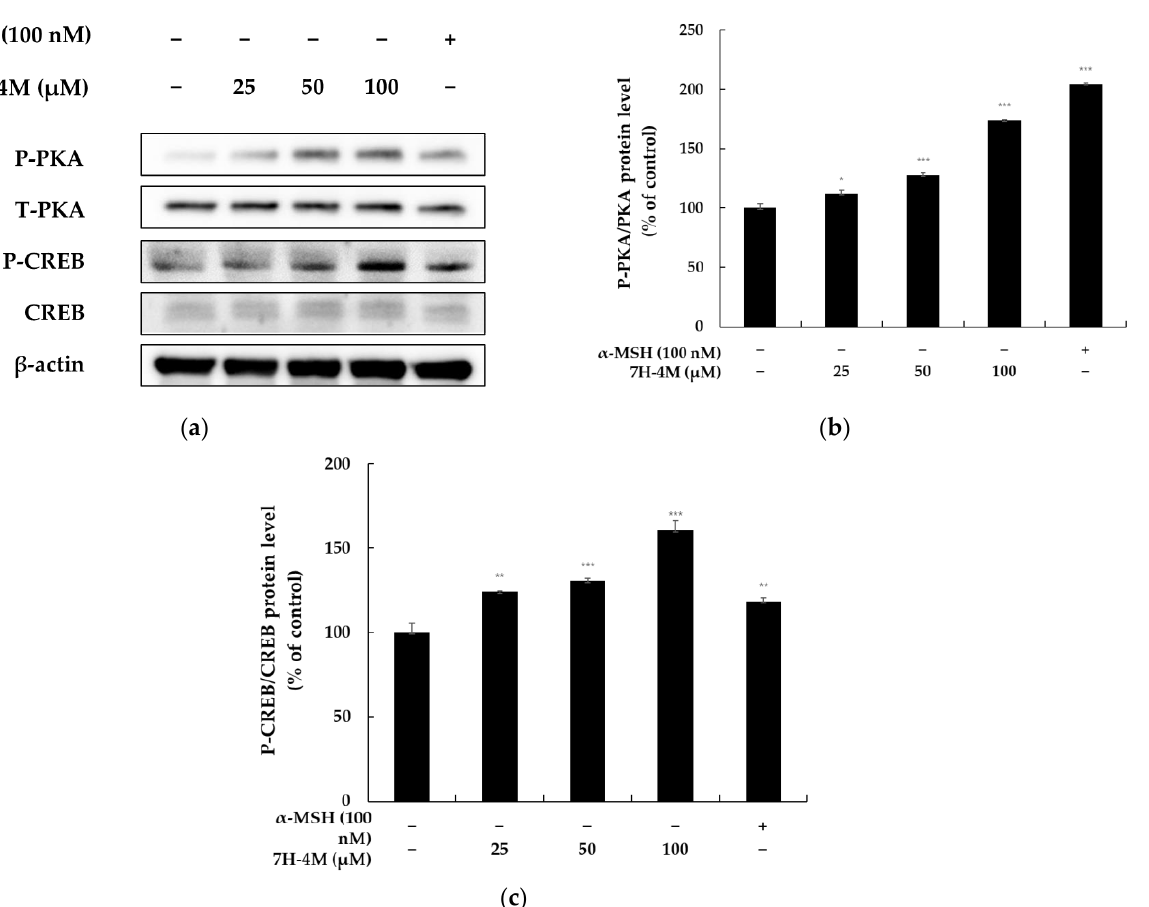
Figure 7. The effect of 7H-4M on the melanogenesis-related protein expression of B16-F10 cells. The cells were treated with 7H-4M at specified concentrations for 24 h, followed by harvesting. Protein extracts were then prepared from each treatment group to evaluate the expressions of P-PKA and P-CREB. Using ImageJ software, the relative intensity of the protein band was quantified and normalized to that of the corresponding loading control. The untreated cells were considered as 100%. ( a ) Western blotting results and ( b ) P-PKA, and ( c ) P-CREB protein expression. The results are shown as mean ± SD of at least three independent experiments, with *** p < 0.001, ** p < 0.01, and * p < 0.05 indicating significance compared to the control group.